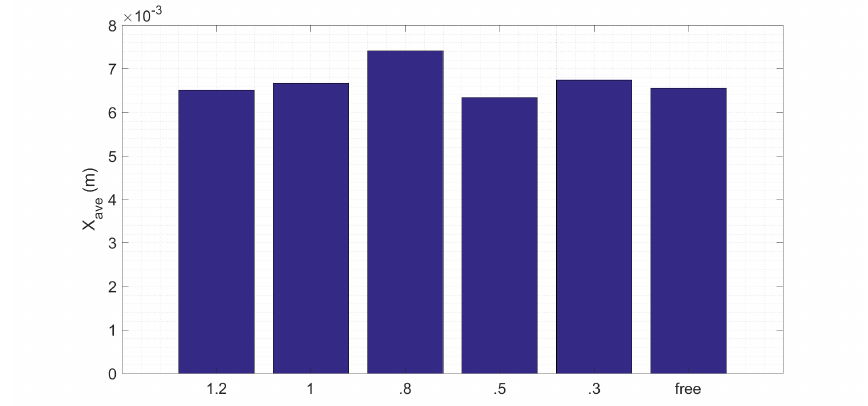
Figure 7. Average distortion versus gap distance